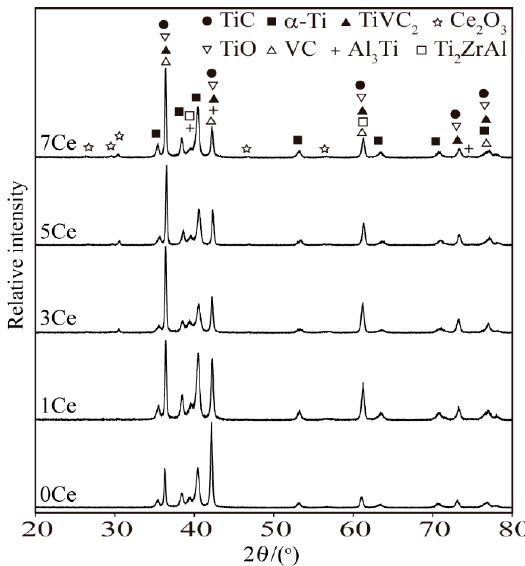
Figure 3. X-ray diffraction (XRD) spectrums of the coatings.